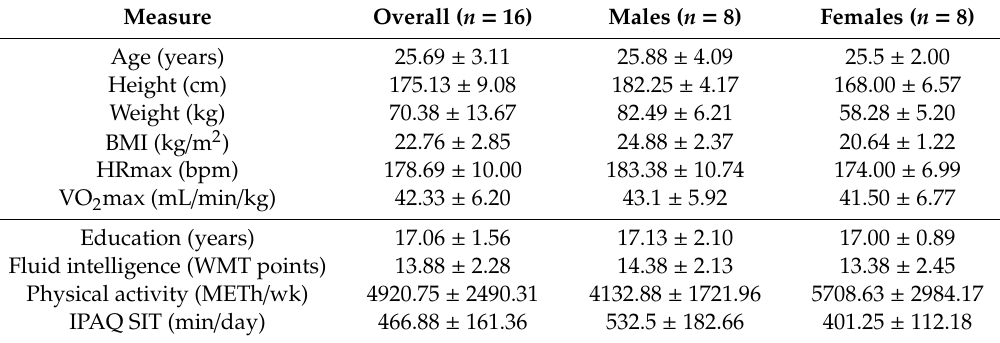
Table 1. Participant demographics and fitness values (mean ± 1 SD).